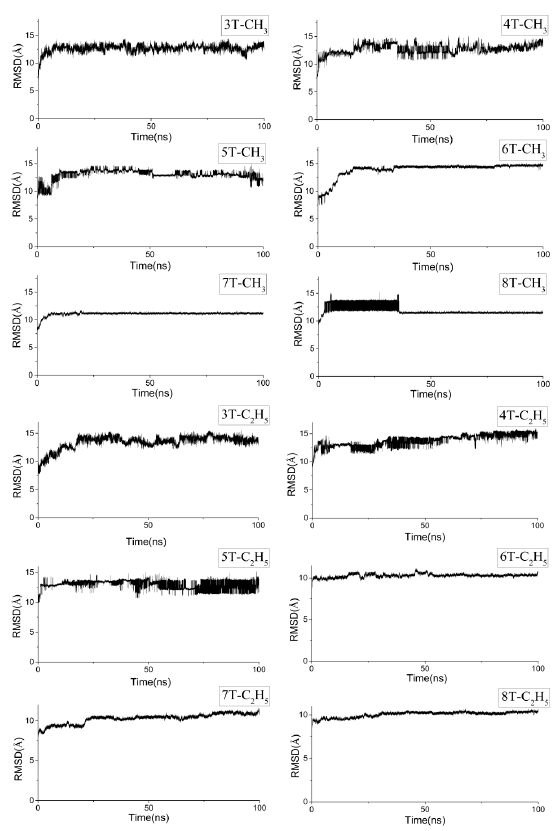
Figure 3. The root mean square deviations (RMSDs) of all the systems during the dynamic